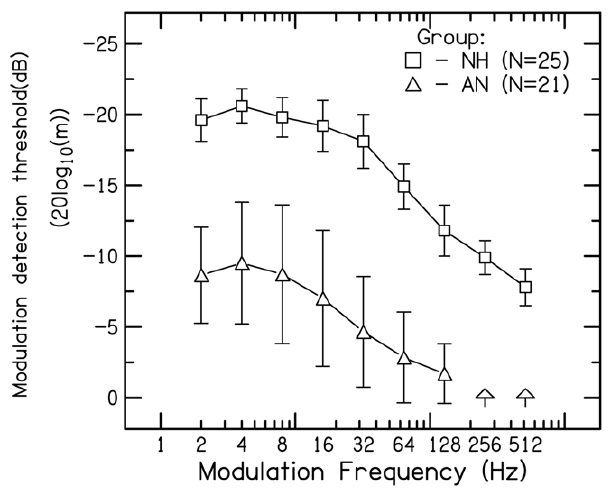
Figure 1. Amplitudemodulation detection thresholds as a function of modulation frequency in listeners with normal hearing (NH) and those with auditory neuropathy (AN). The opensquarefornormal hearing, open trianglefor listeners with AN. The open trianglewith downward arrow indicates thresholds . 0 dB.